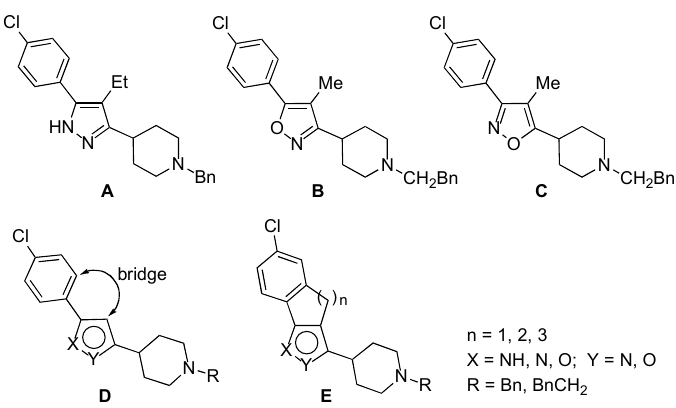
Figure 1. Leads and target molecules.